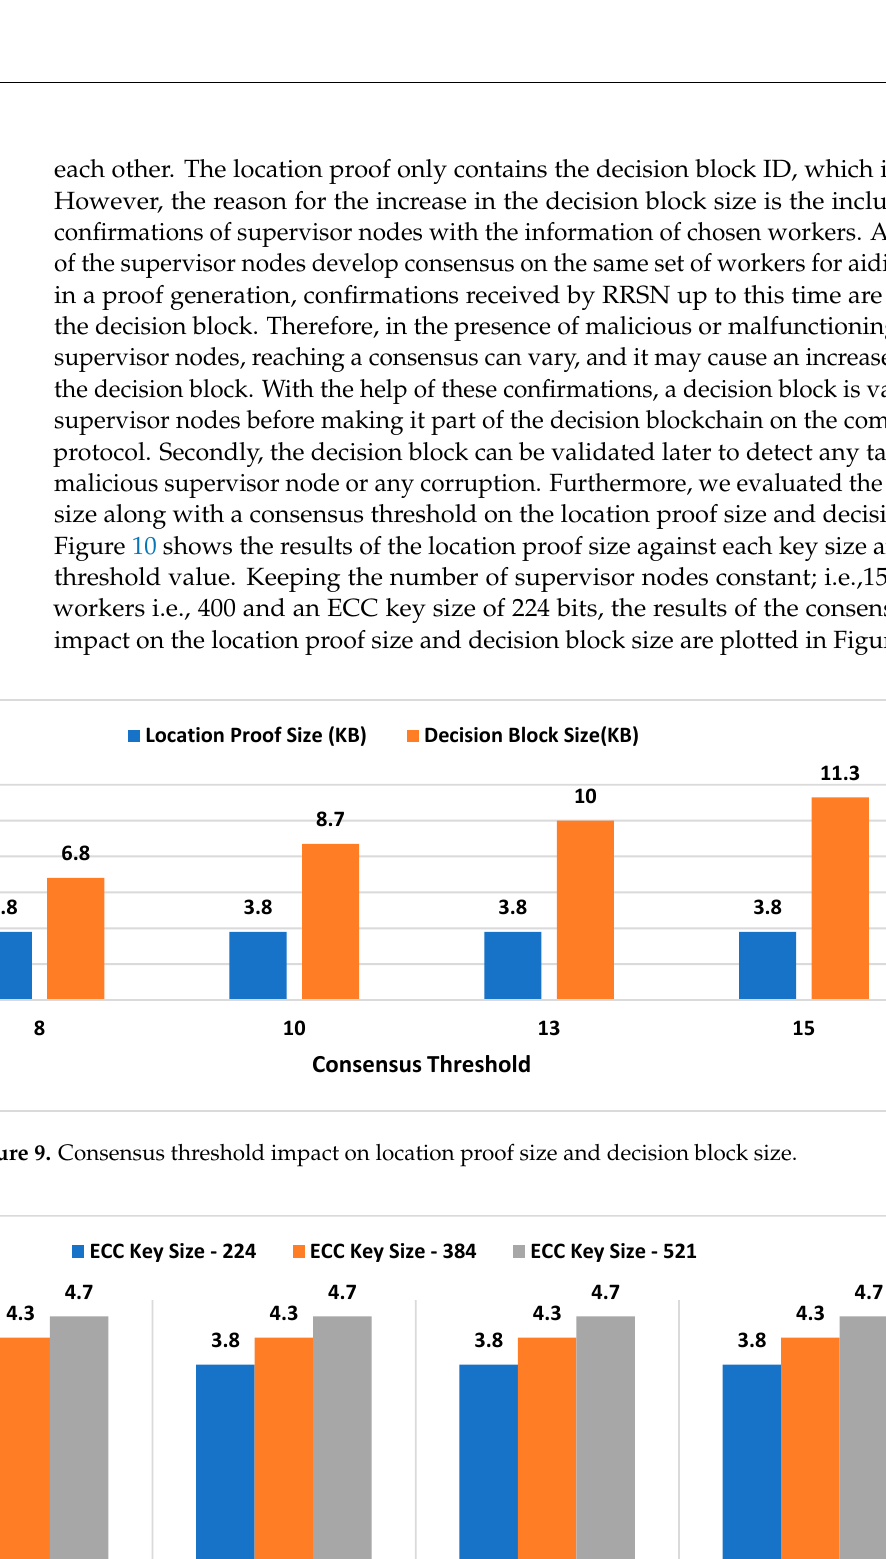
Figure 8. Consensus threshold and key size impact on proof generation time.